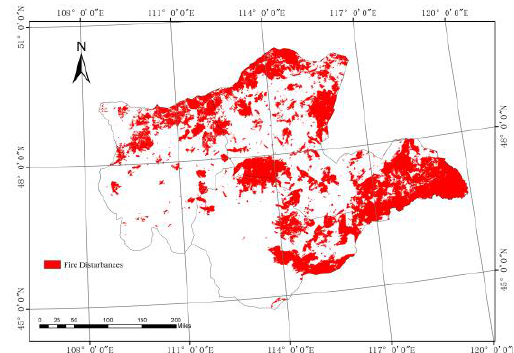
Figure 2.The Spatial Distribution of Fires (a) fire disturbance